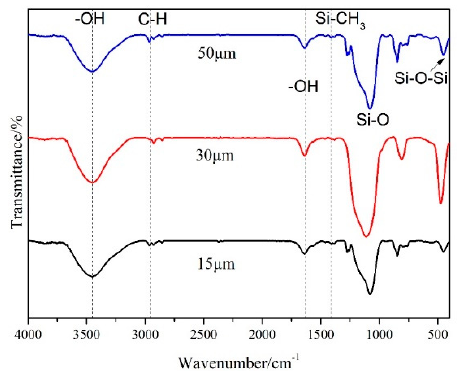
Figure 3. Infrared spectra of silica aerogels with different particle sizes.